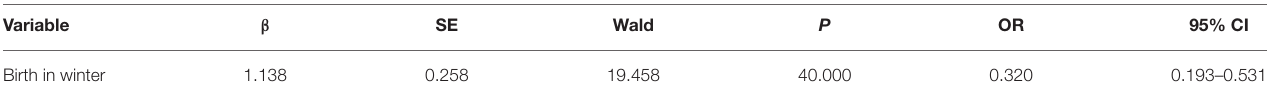
TABLE 4 | Multivariate logistic regression analysis predicting the risk vitamin D insufficiency in full-term